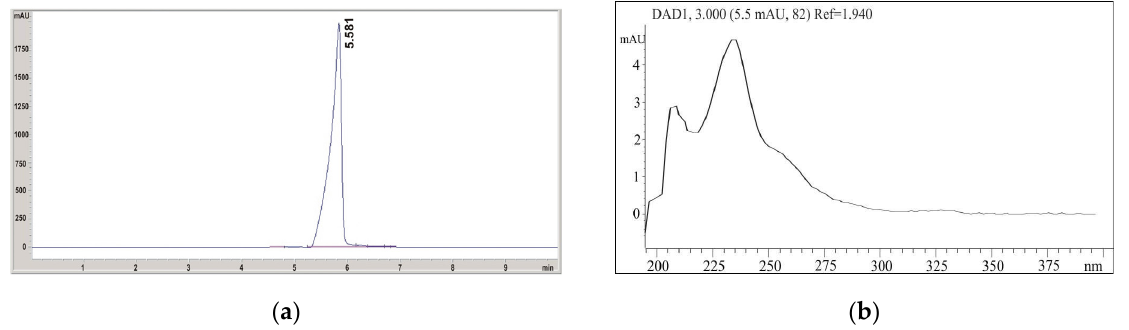
Figure 8. ( a ) Chromatogram of naproxen from HPLC, ( b ) UV spectrum from DAD detector.